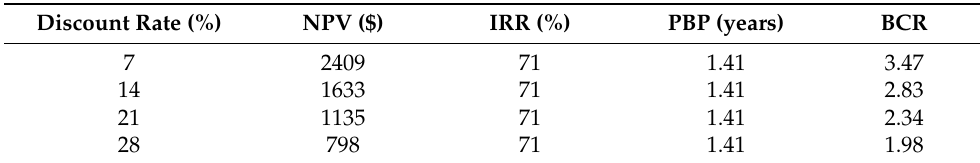
Table 6. Variation of NPV, IRR, PBP, and BCR in relation to the discount rate. Discount Rate